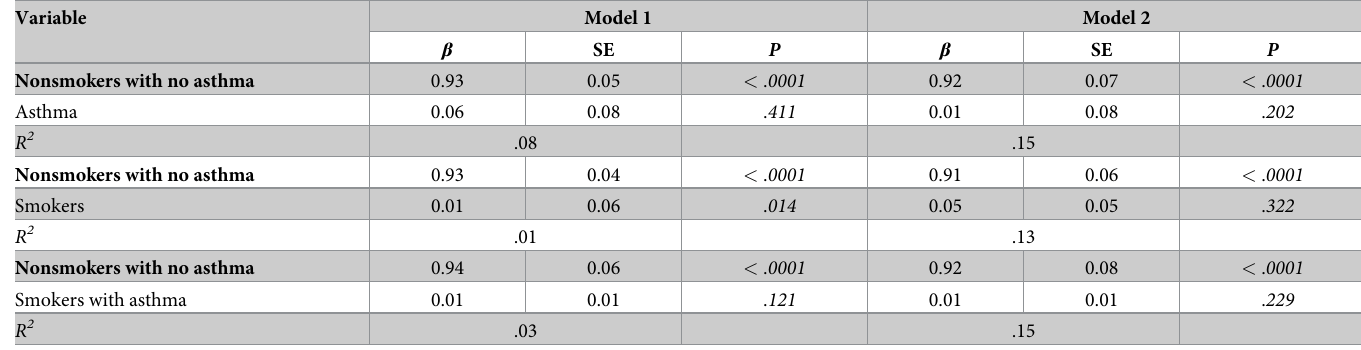
Table 5. Associations of asthma and smoking with a waist-to-hip ratio.